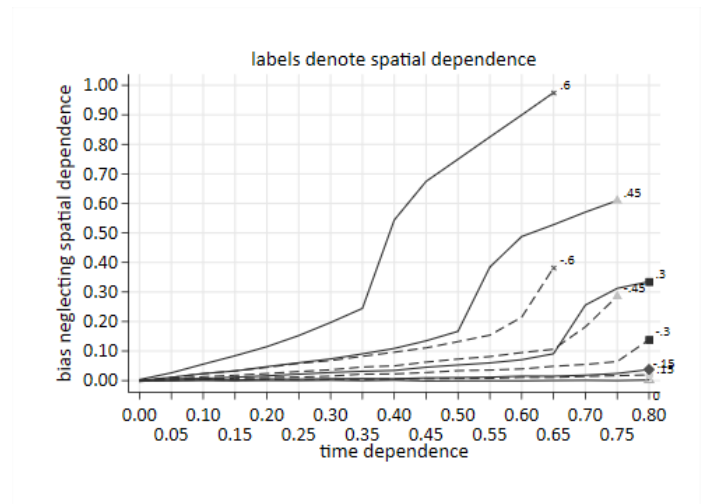
Figure E.3: Bias of Team Dynamic neglecting the spatial dimension. The vertical axis describes γ TD − γ 0 , the horizontal axis depicts γ 0 . Labels denote spatial dependence in the DGP ( λ 0 ). Based on German NUTS 2 regions.